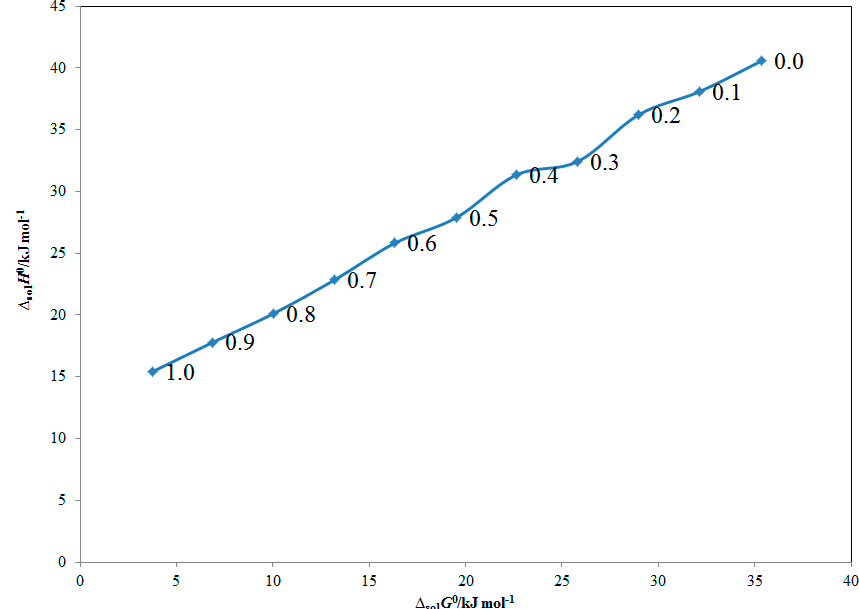
Figure 4. Apparent standard enthalpy ( ∆ sol H 0 ) vs. apparent standard Gibbs energy ( ∆ sol G 0 ) enthalpy– entropy compensation analysis graph for FFA solubility in various mixed solvent systems at the mean harmonic temperature ( T hm ) = 308 K.